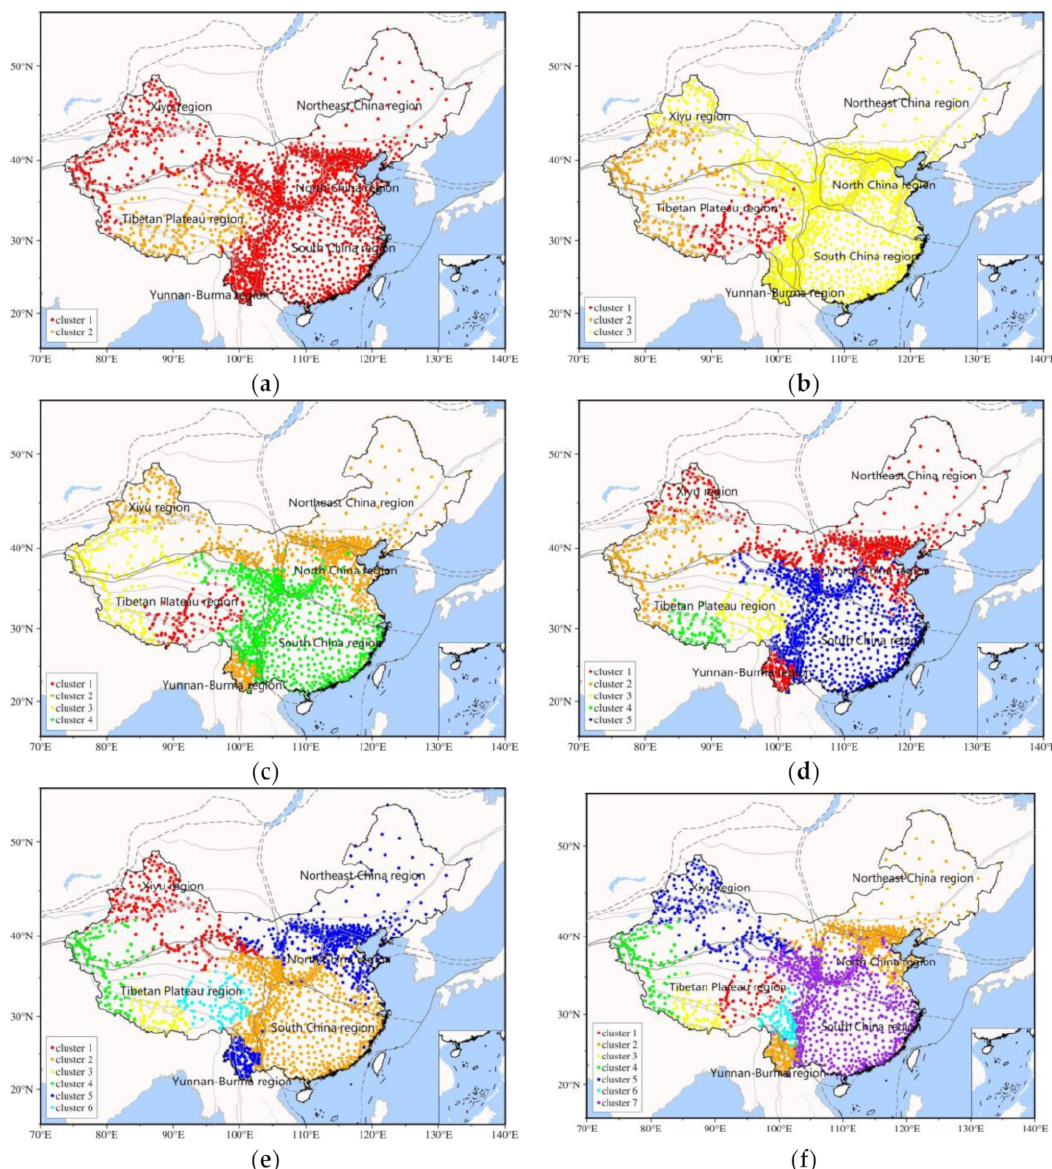
Figure 12. The results of block division with K-means++ clustering method. ( a ) Two clusters. ( b ) Three clusters. ( c ) Four clusters. ( d ) Five clusters. ( e ) Six clusters. ( f ) Seven